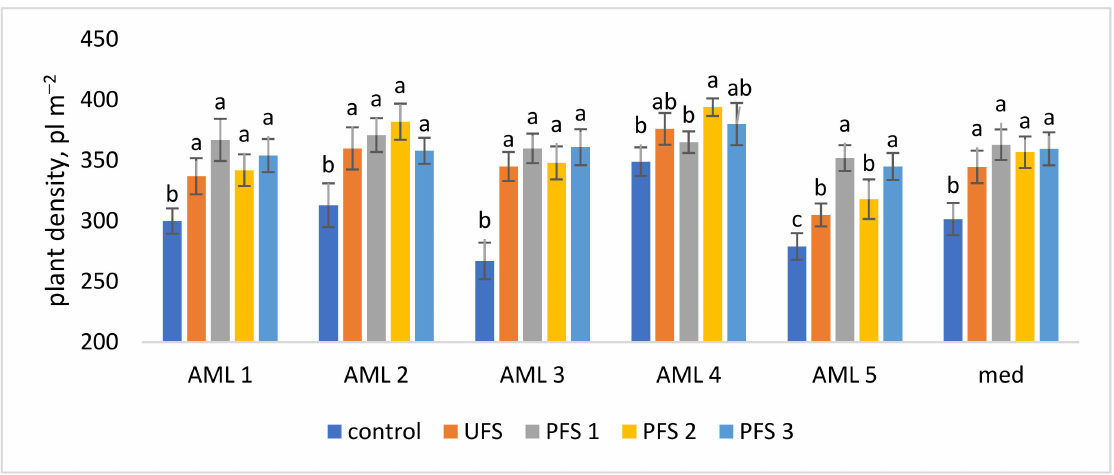
Figure 3. Plant density of winter wheat crops in the phase of full